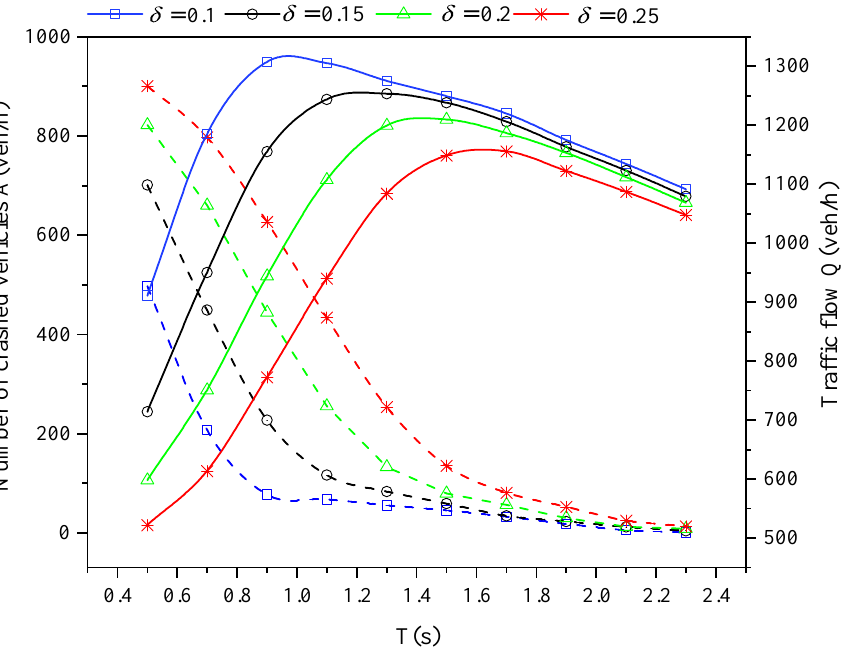
Figure 3. Traffic flow and crashed vehicles for varying T and perceptual error size δ in a completely CAV scenario with an independent on-board sensor perception